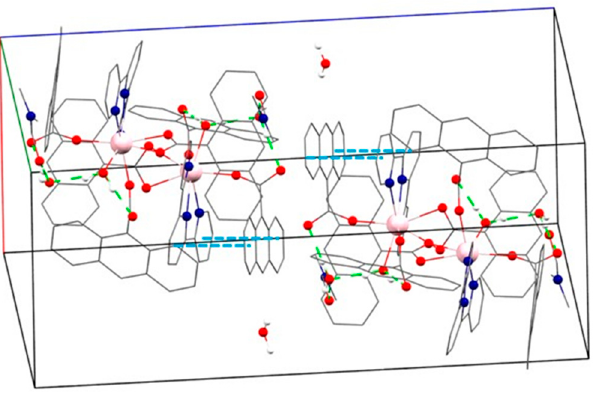
Figure 4. Hydrogen bond (green dashed line) and π – π stacking (blue dashed lines) in 4Er . The compounds also present π – π stacking interactions between different aromatic rings. One of them is given within each molecule [Ln(9-anthc) 3 (TPY)(H 2 O)] between the TPY ligand rings (Cg(1) from the Supporting Information, Table S3) and the anthracene group of the monodentate ligand containing the oxygen atoms O1 and O2 (Cg (6)‘or Cg (7)’ from the Supporting Information, Table S3). The intermolecular contacts vary slightly according to the Ln(III) ion. In the case of the Tb(III) and Dy(III) compounds, the TPY rings of each mononuclear unit interact with two different neighbor molecules via the corre- sponding terpyridine ligands. Thus, there is an interaction between the ring that contains the N1 atom with the ring that contains the N2 atom of a neighboring molecule (Cg (1)– Cg (2)’ from the Supporting Information, Table S3) and another supramolecular contact of the TPY ligand ring that contains the N3 nitrogen with the same ring of another adjacent molecule (contact Cg (3)–Cg (3)’ from the Supporting Information, Table S3). On the other hand, the compounds [Ln(9-anthc) 3 (TPY)(H 2 O)] with Ln (III) = Er and Yb have a single supramolecular contact type π – π , which is also through the TPY ligands, aromatic ring containing the N1 atom of the reference molecule with the ring containing the nitrogen N3 of the neighboring molecule (Supporting Information, Figure S1). 2.1.3. Structural Discussion The key to obtaining the structural types I and II for the described compounds by using the same synthetic method is the contraction of the ionic radius within the series of the lanthanide elements. As described, for the Eu(III) ion, with the largest ionic radius, the nona-coordinate coordination sphere is due to the coordination of three carboxylate lig- ands 9-anthc, two in chelating mode and one in monodentate mode, and for the coordi- nation of a DMF molecule. For the Tb(III), Dy(III), Er(III), and Yb(III) ions, the compounds have been obtained with an octa-coordinate environment since the decrease in ionic ra- dius causes two of the three 9-anthc anions to be coordinated in monodentate mode and the last to be coordinated in chelating mode. This structural change is also accompanied by the coordination of a molecule of water instead of a DMF molecule. 2.2. Magnetic Properties 2.2.1. dc Magnetic Studies Magnetic susceptibility ( χ M ) data on polycrystalline powder samples of 1Eu - 5Yb were collected under fields of 3000 G (300–30 K) and 200G approximately (30–2 K). The data are represented as χ M T vs. T plot in Figure 5a.